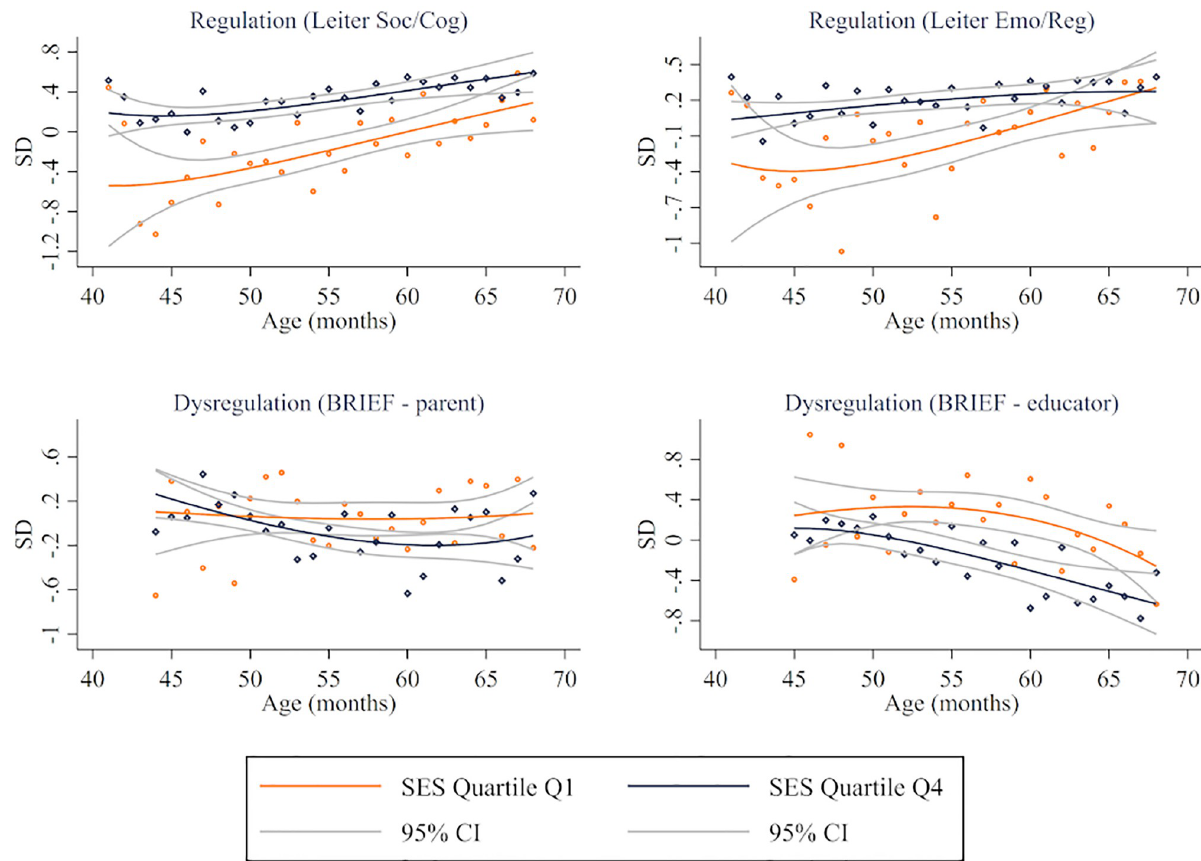
Fig 3. Regulatory-related skills by age by SES quartile. Fractional-polynomial plots by developmental domain.